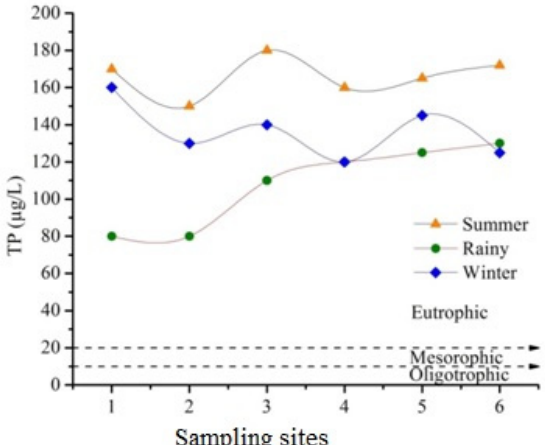
Fig. 3: Seasonal deviations in total phosphate concentrations